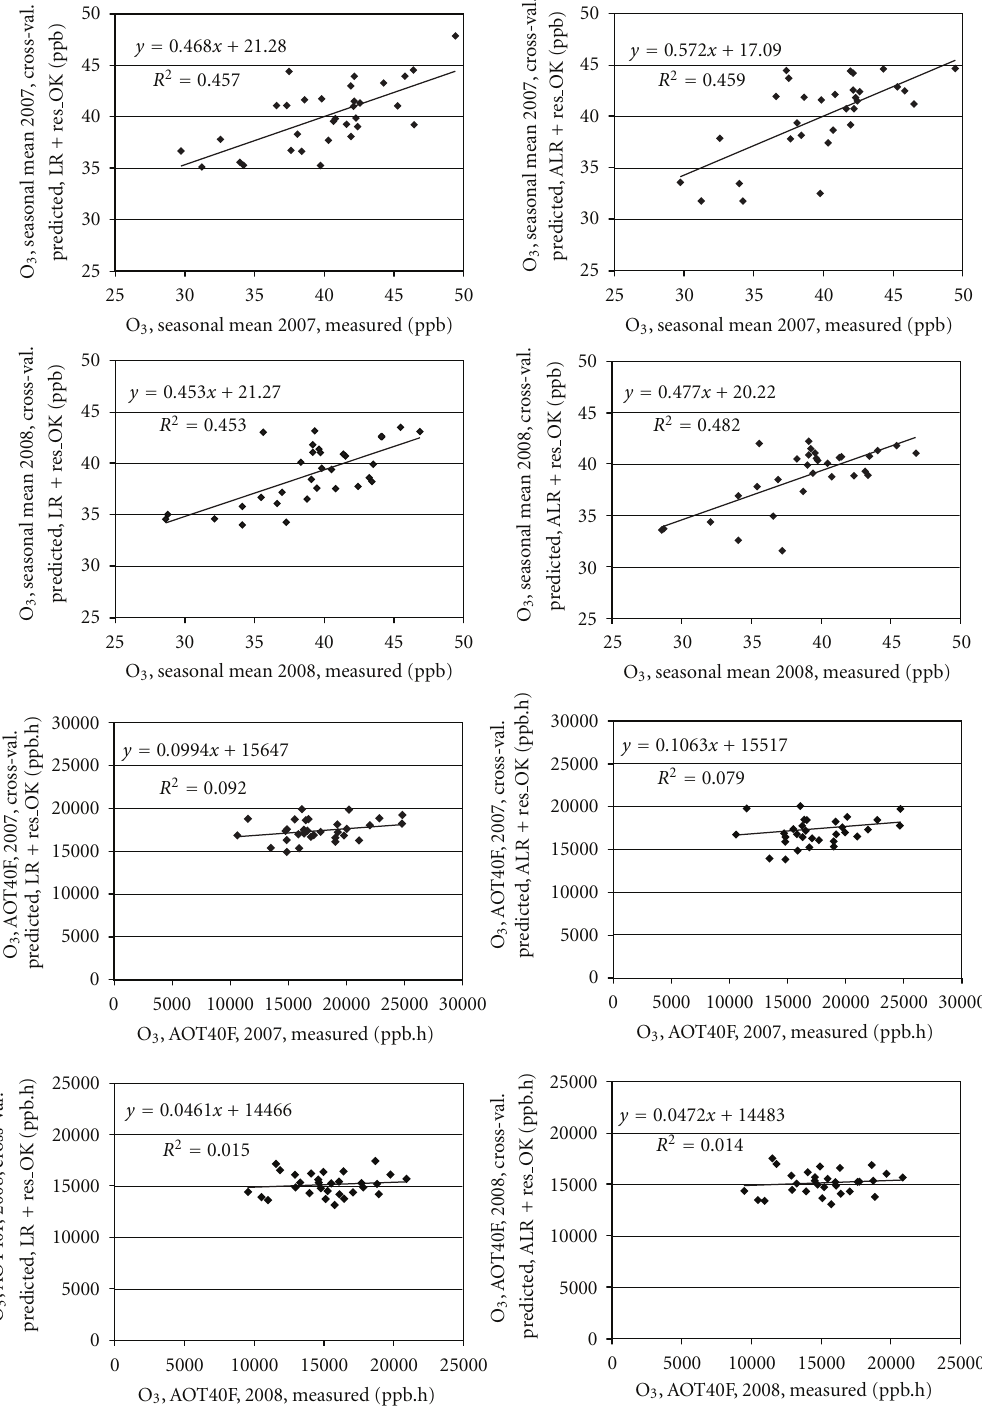
Figure 6: Scatter plots showing the relationship of cross-validation interpolated and measured values for the interpolation techniques LR + res OK (left) and ALR + res OK (right) for (a) seasonal mean O 3 concentrations (b) exposure index AOT40F.